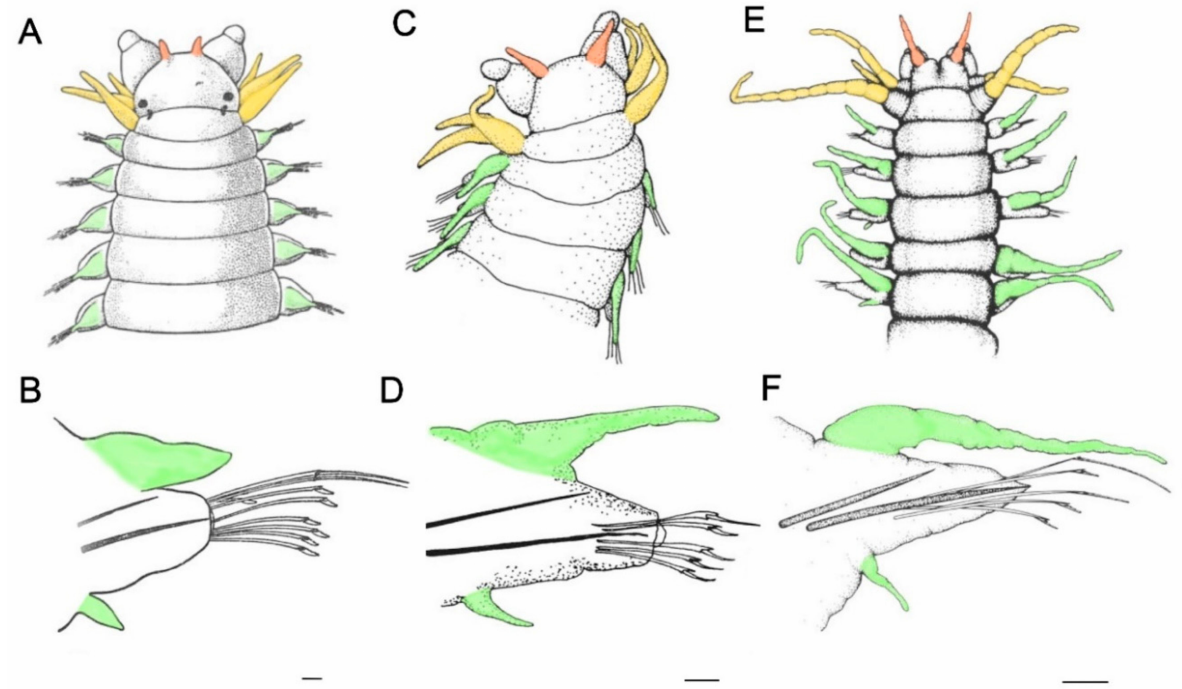
Figure 4. Typical morphology of Namanereis (Nereididae) exemplified by Namanereis littoralis ( A , B ), compared to the secondary troglomorphic traits in Namanereis beroni ( C , D ) and Namanereis araps ( E , F ), including loss of eyes, elongation of antennae, tentacular and parapodial cirri, and increase in length of the terminal blades of the articulated falcigerous chaetae (bar showing relative length). Adapted from Glasby et al. (2014: Figure 7